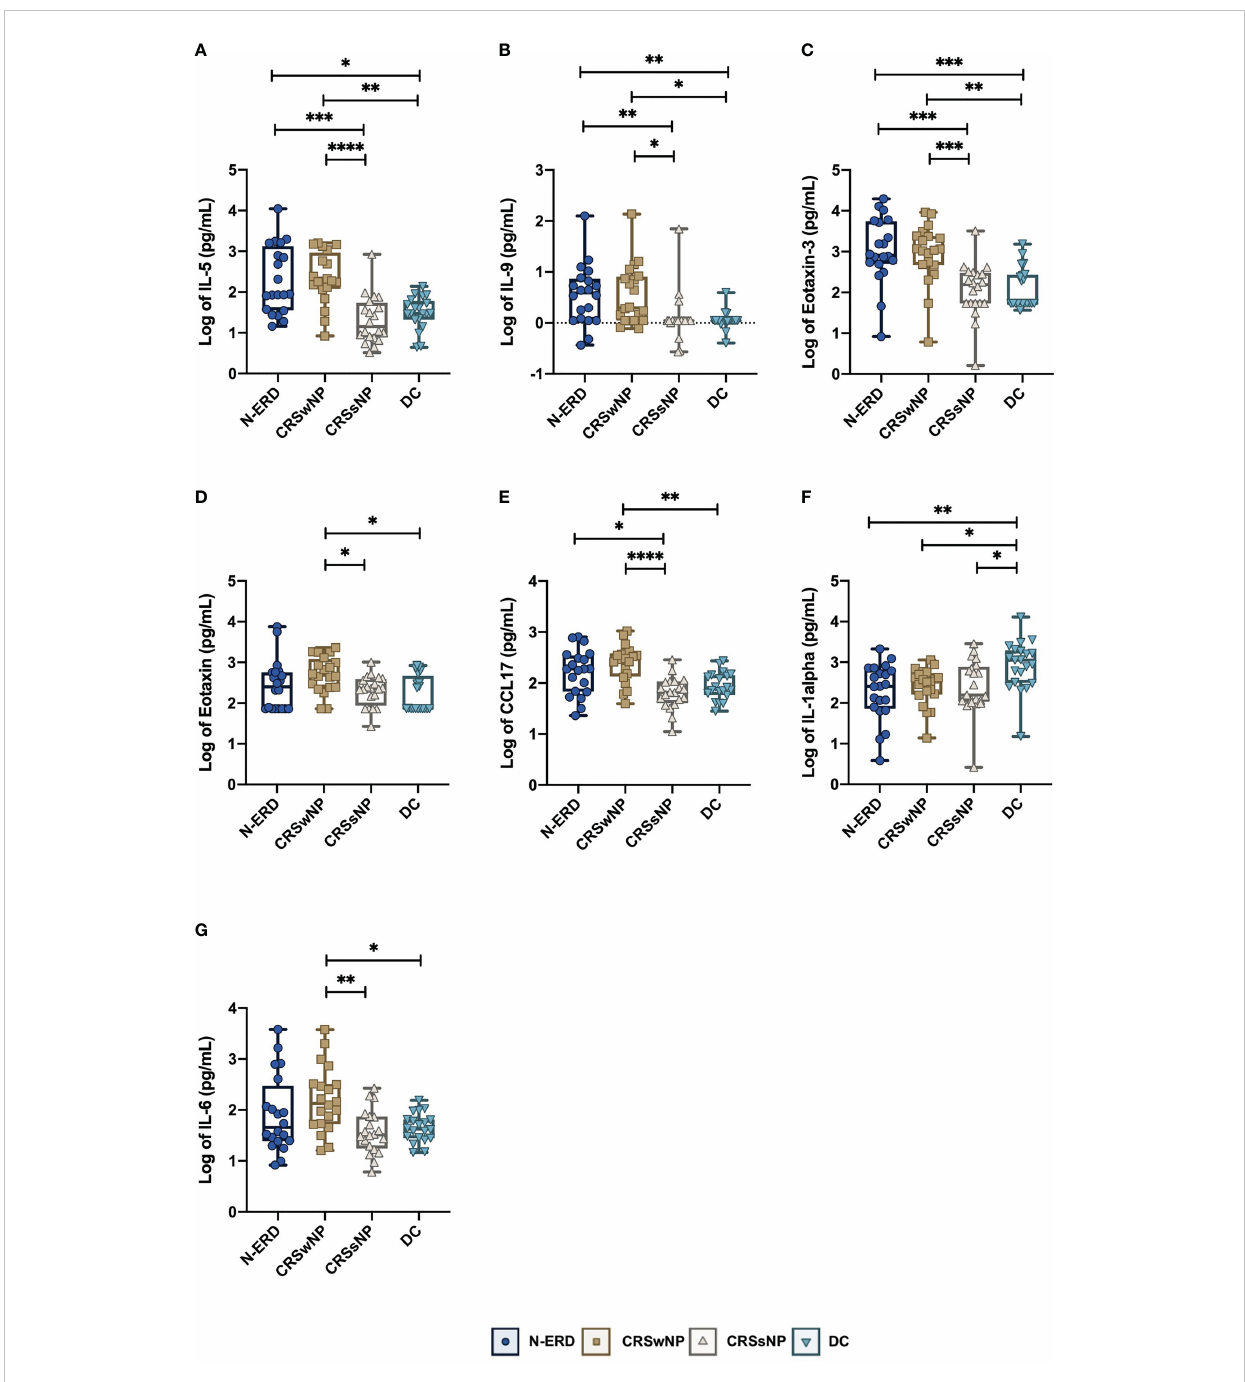
FIGURE 2 Selected mediator levels in nasal secretion in patients suffering from chronic rhinosinusitis with (CRSwNP), without nasal polyposis (CRSsNP), non- steroidal anti-in fl ammatory drug-exacerbated respiratory disease (N-ERD) as compared to disease controls (DC). (A-I) Levels of (A) IL-5, (B) IL-9, (C) Eotaxin-3, (D) Eotaxin, (E) CCL17, (F) IL-1 a , (G) IL-6 are displayed as log-transformed mean concentration (y-axis, pg/ml) in patients with CRSsNP (grey triangles, n=20), CRSwNP (brown squares, n=20) or N-ERD (dark blue circles, n=20) as compared to disease controls (DC, light blue triangles, n=20). Stars represent statistically signi fi cant differences between groups using Kruskal-Wallis test (Table E3) followed by Dunn ’ s test (*P ≤ 0.05, **P ≤ 0.01, ***P ≤ 0.001, ****P ≤ 0.0001). Line within each box represents the median, bottom border represents the 25 th percentile and top border the 75 th percentile of the data. Whiskers extend 1.5 times the interquartile range and diamond shaped points are